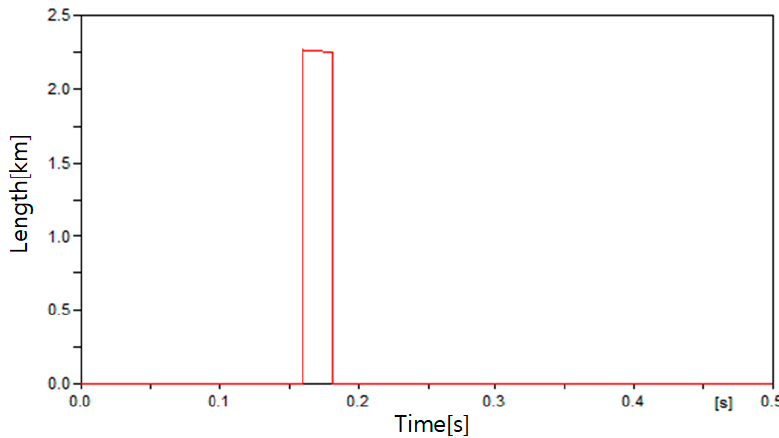
Figure 19. Fault location in Case 5.